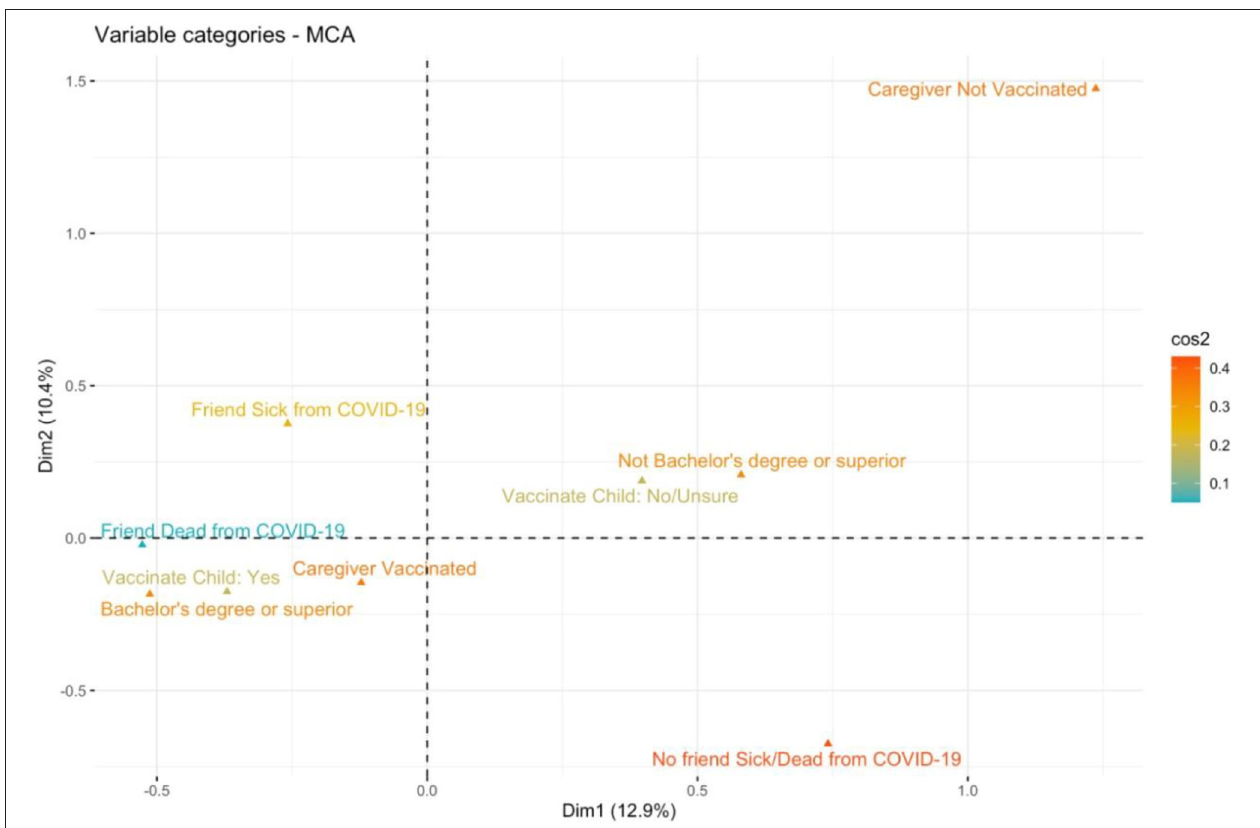
FIGURE 1 | All levels of the categorical variables considered in the univariate analysis were projected in a new space defined by the first two dimensions (Dim1, Dim2) computed by MCA. Only variables showing a possible joint association to the caregiver’s intention to vaccinate the child are displayed. The level “Vaccinate Child: Yes” (i.e., the caregiver willing to vaccinate the child), the level “Bachelor’s degree or superior” (i.e., the caregiver holding a bachelor’s degree or higher level of education) and the level “Caregiver Vaccinated” (i.e., the caregiver has completed/is about to complete the primary vaccination course) are close in the multivariate space, indicating a possible joint association. The categories of the variables are colored considering the parameter of cos2, which measures the degree of association between variable categories and a particular axis. If a variable category is well-represented by two dimensions, the sum of the cos2 is closed to one and tends to red